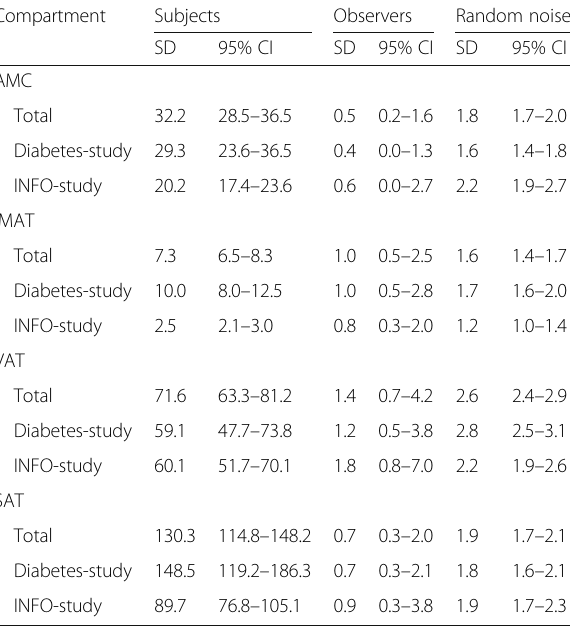
Table 3 Distribution of variation between subjects, observers and random noise per study